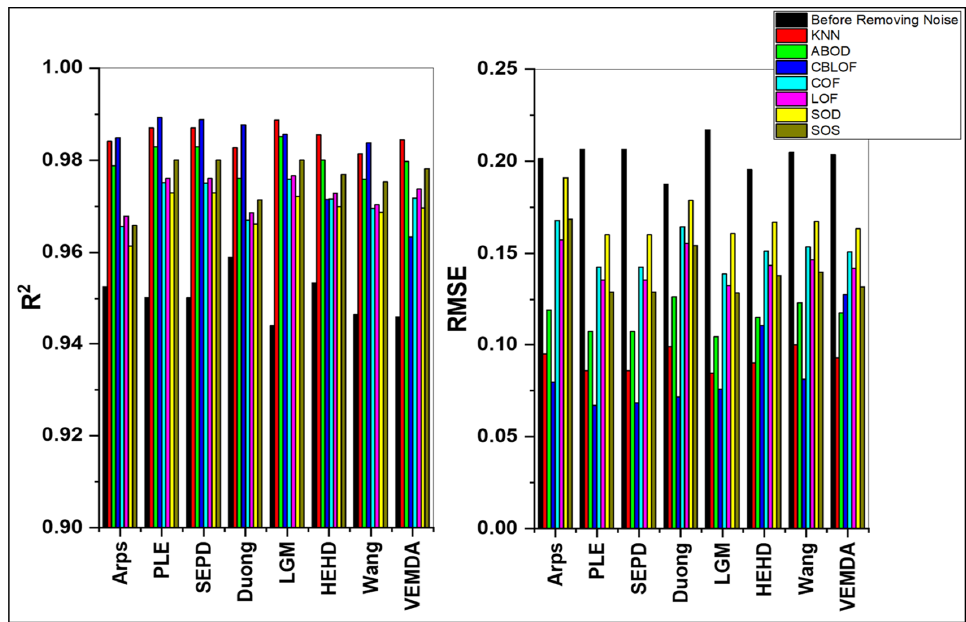
Figure 26. Well_12; R 2 and RMSE after applying eight DCA models before and after removing the noise using the seven algorithms.